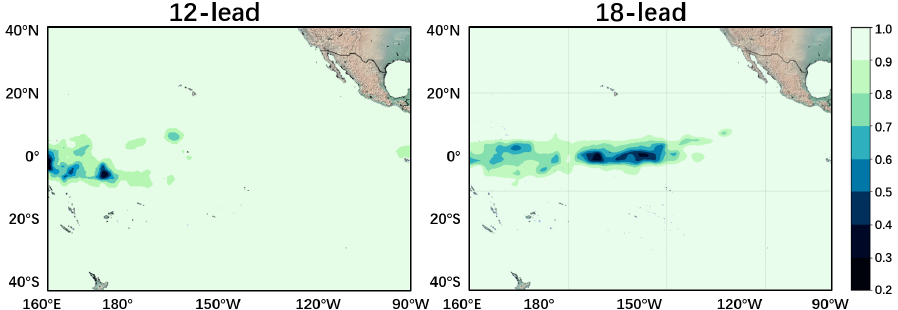
Figure 16. The spatial covariance heat map between the forecast results of the ENSO-ASC and real-world observations with 12 and 18 lead months over the validation period.